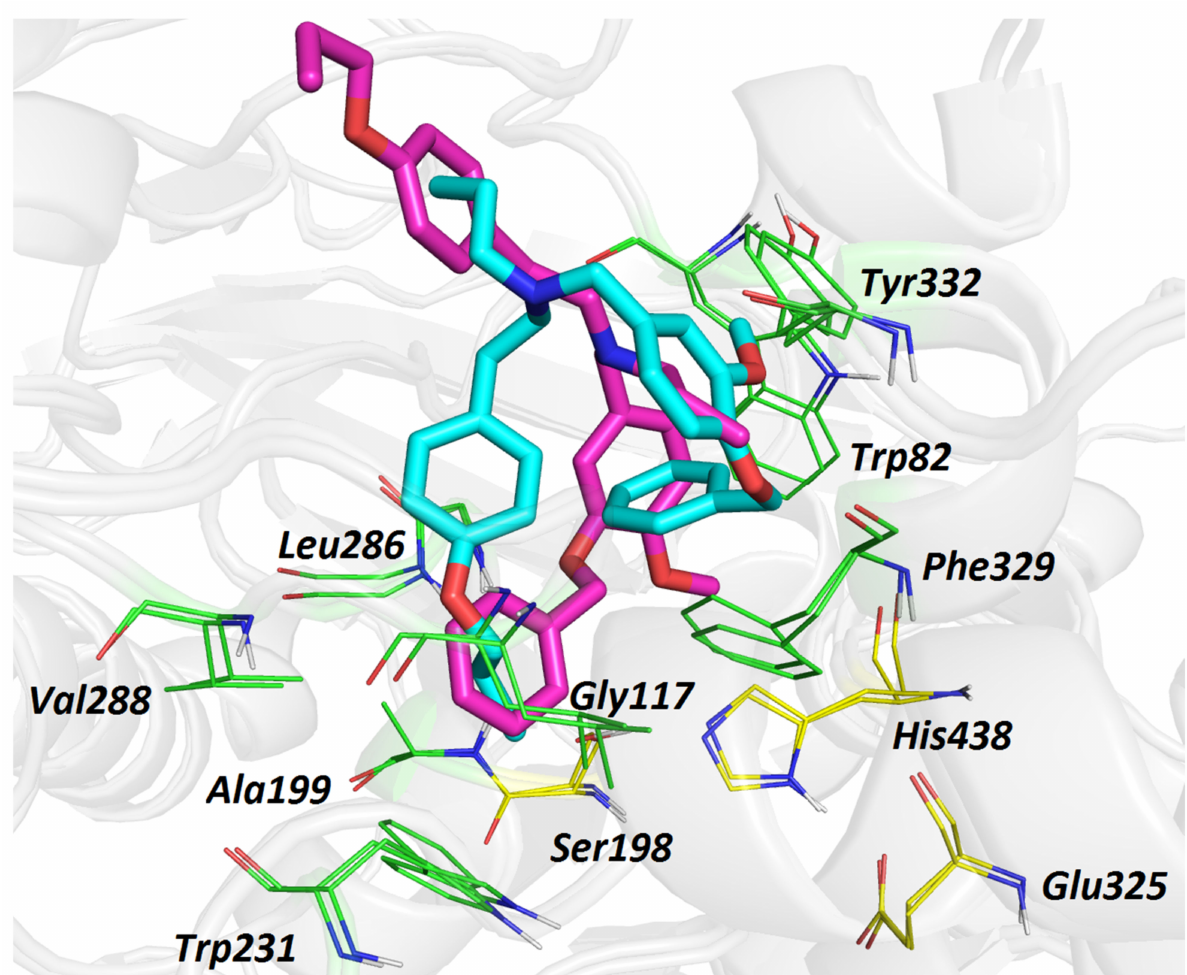
Figure 4. Overlapped top-scored poses for ligands 5 (light blue) and 6 (purple) in the active site of h BuChE (PDB ID: 6QAA) [43]. Amino acid residues involved in the interactions with ligands are depicted as either green or yellow (catalytic triad) lines. The rest of the receptor is displayed in light-grey cartoon conformation. Figure was created with The PyMOL Molecular Graphics System, Version 2.4.1, Schroödinger,